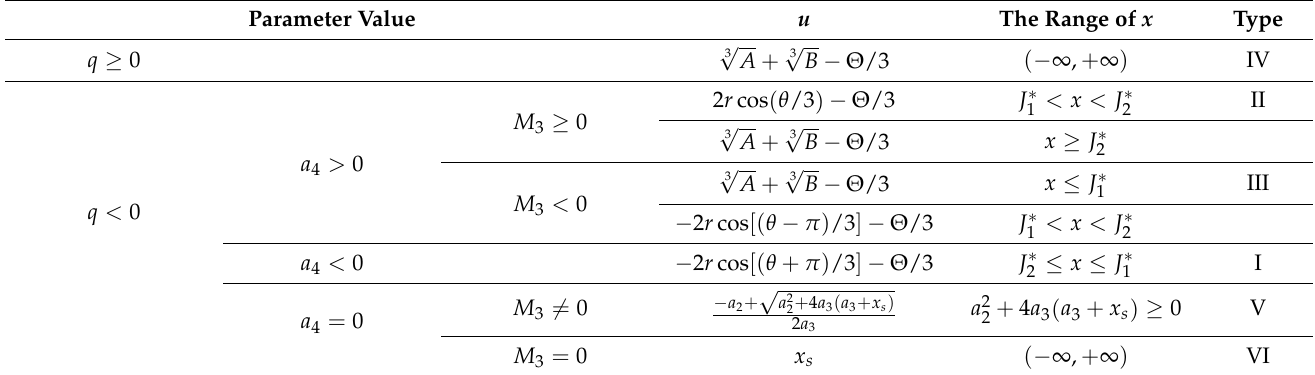
Table 2. The division criterion of standardized transformation random variable u Parameter